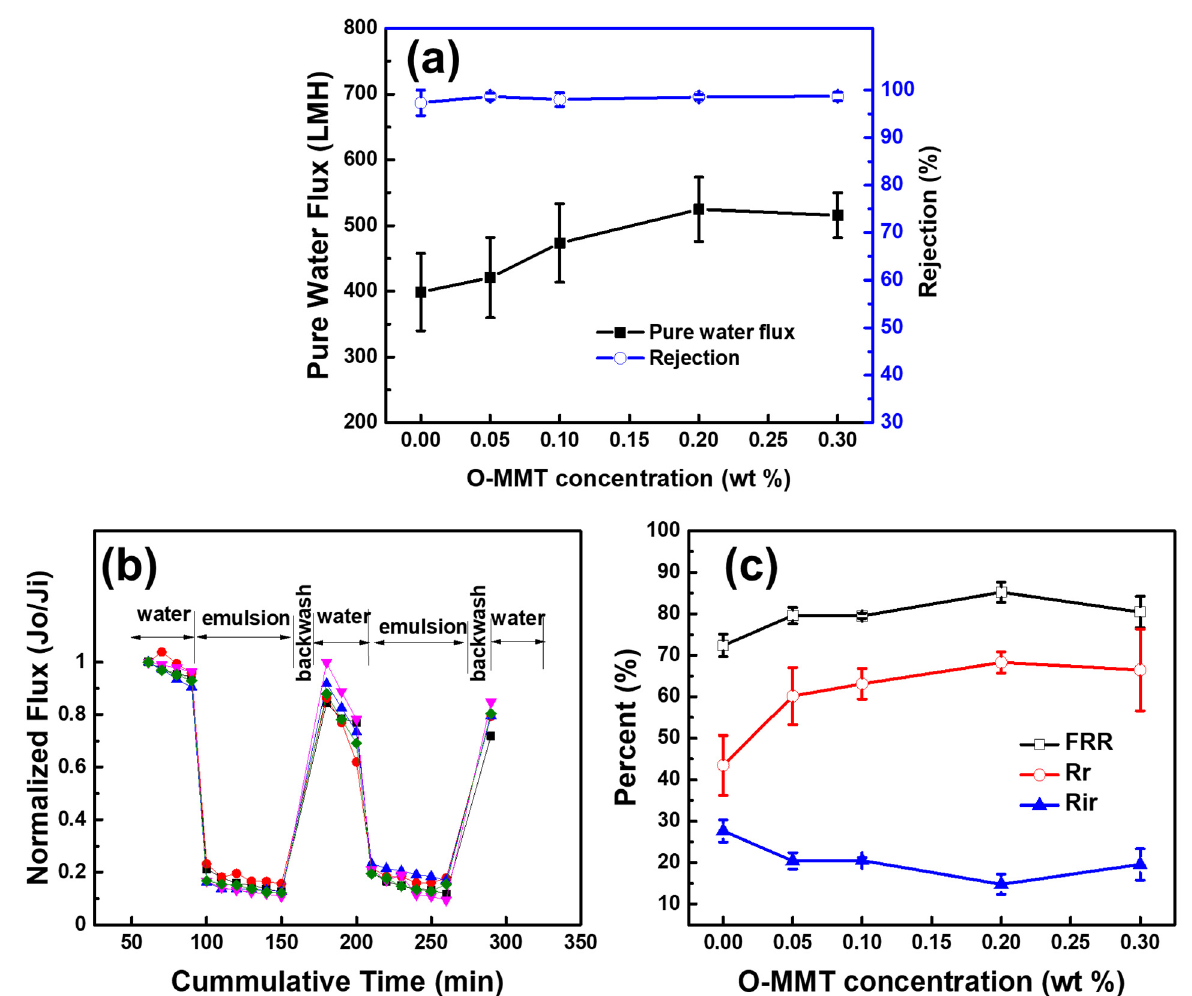
Figure 6. Effect of O-MMT concentration on ( a ) membrane performance and ( b , c ) antifouling property.